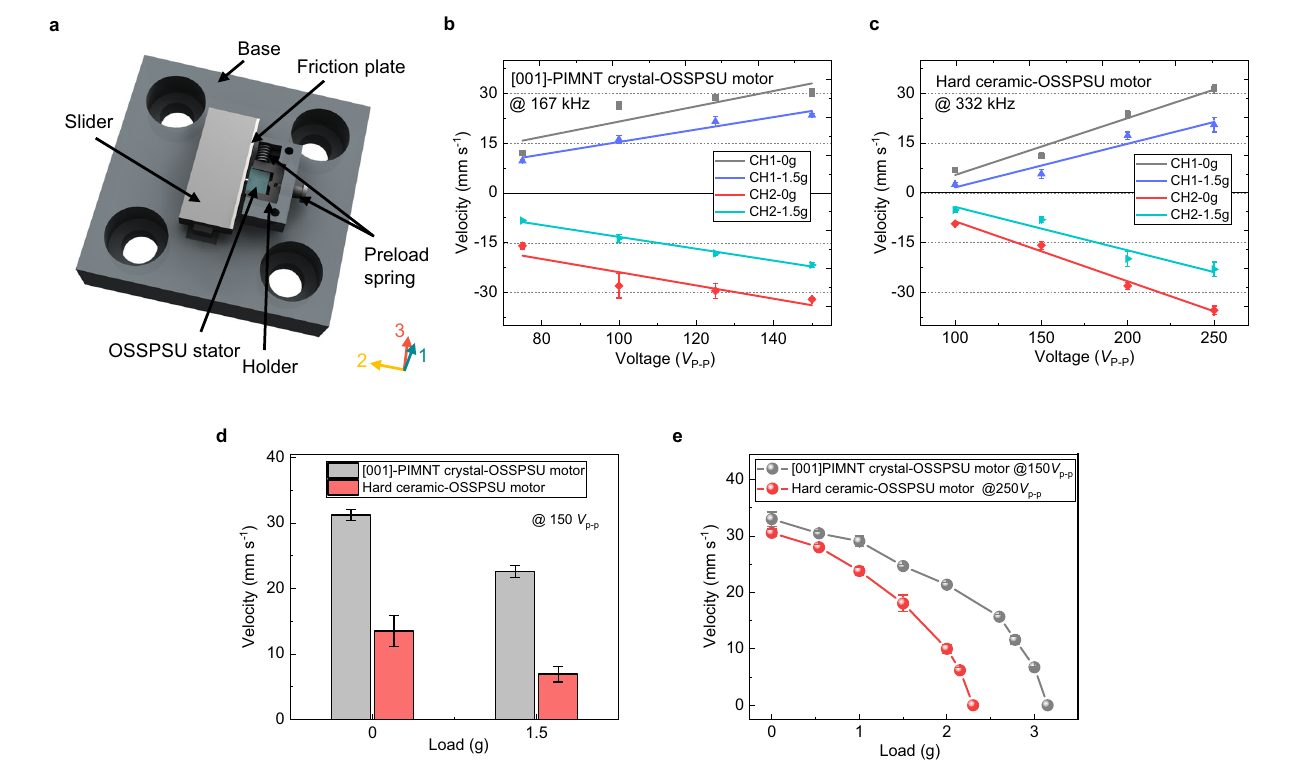
Fig. 5 | Schematic of the proposed miniature linear OSSPSU motor and the velocity performance for the OSSPSU motors. a Basic design of the miniature linear ultrasonic OSSPSU motor. b The relationship between the bidirectional motion velocities of [001]-PIMNT crystal-OSSPSU motor and the applied voltage and load. c The relationship between the bidirectional motion velocities of hard ceramic-OSSPSU motor and the applied voltage and load. d Comparison of the